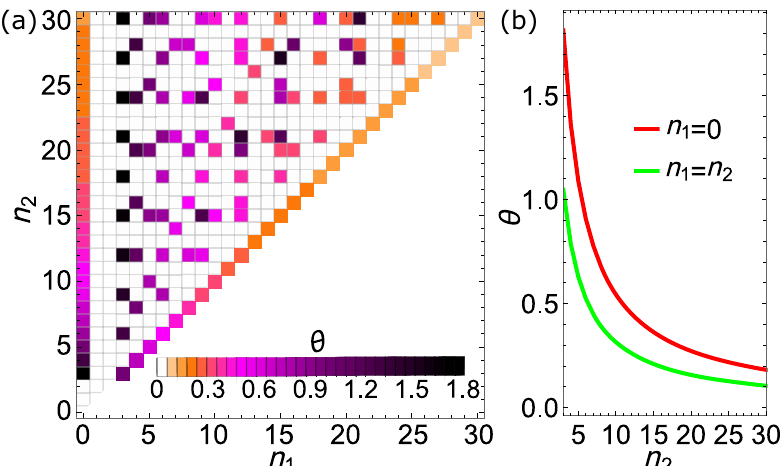
Fig. 4 Evaluation of θ . Values of θ for ( a ) ( n 1 , n 2 ) CNTs with rotational symmetry C N ( N > 2) and ( b ) zigzag (red) and armchair (green)